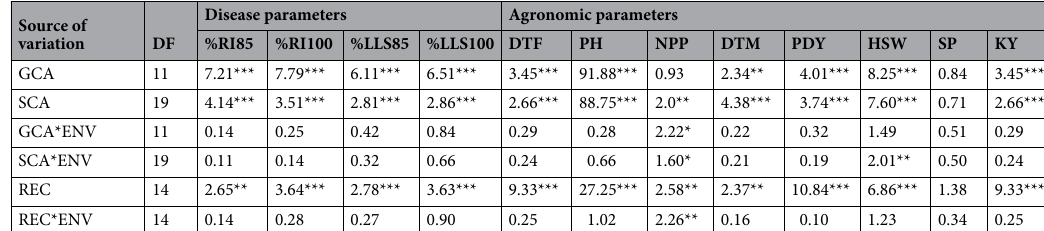
Table 6. Analysis of variance showing F-statistic for combining ability effects for four disease parameters and eight agronomic traits of 45 groundnut genotypes evaluated in two seasons in Tanzania. DF degrees of freedom, %RI85 percentage rust infection at 85 days after planting, %RI100 percentage rust score infection at 100 days after planting, %LLSI 85 Percentage late leaf spot infection at 85 days after planting, %LLSI 100 percentage late leaf spot infection at 100 days after planting, DTF days to flowering; PH plant height, NPP number of pods per plant, DTM days to maturity, PDY pod yield, HSW hundred seed weight, SP shelling percent, KY kernel yield, GCA general combining ability, SCA specific combining ability, ENV environment/ season; REC reciprocal, GCA*ENV general combining ability by environment/season interaction, SCA*ENV specific combining ability by environment/season interaction, REC*ENV reciprocal by environment/season interaction. *,** and *** represent significant differences at 0.05, 0.01 and 0.001 probability levels, respectively.